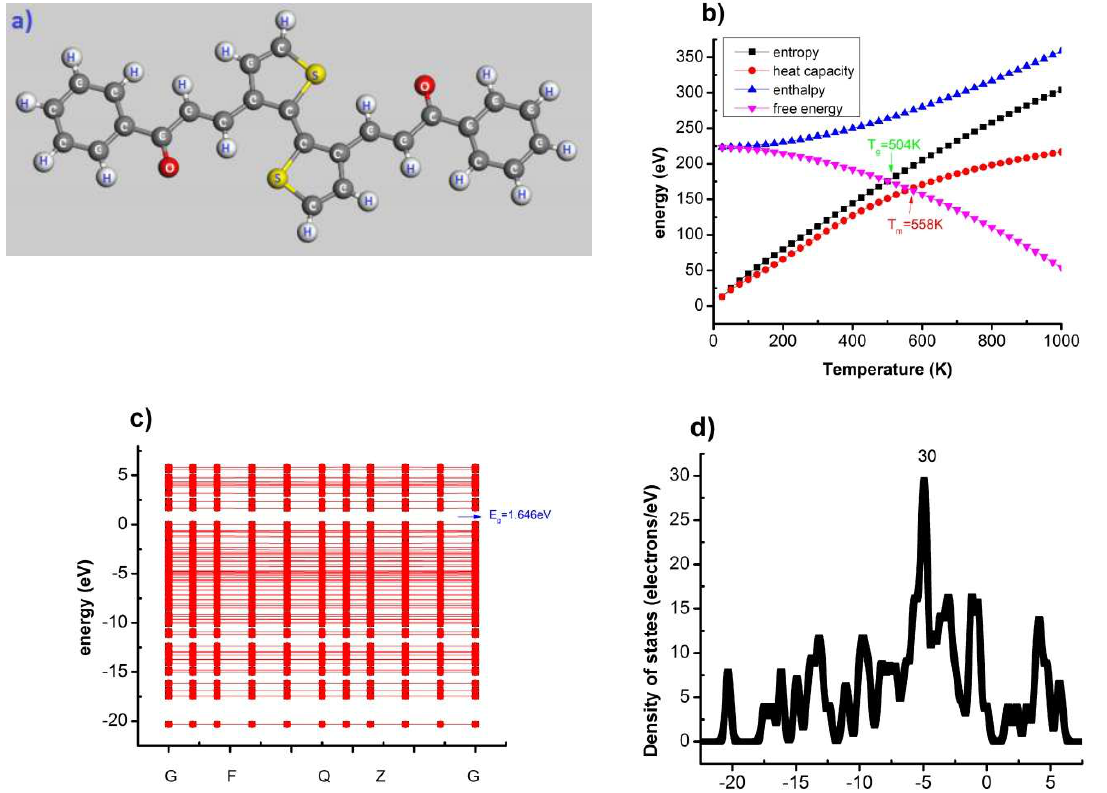
Figure 2. The quantities characteristic of the structure, and electronic structure of poly(C 13 H 8 OS–H) materials such as Shape ( a ), phase transition temperature zone ( b ), electronic structure ( c ), and the density of states ( d ).